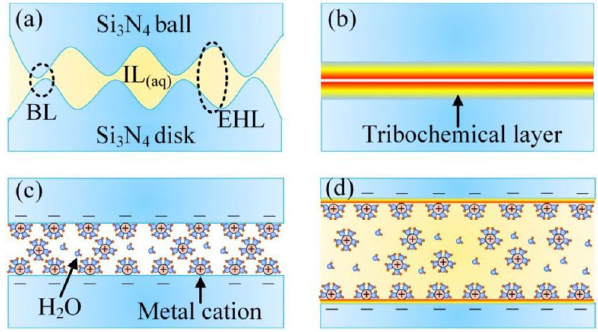
Fig. 10 Proposed superlubricity and antiwear model. Reproduced with permission from Ref. [94]. © American Chemical Soeity,